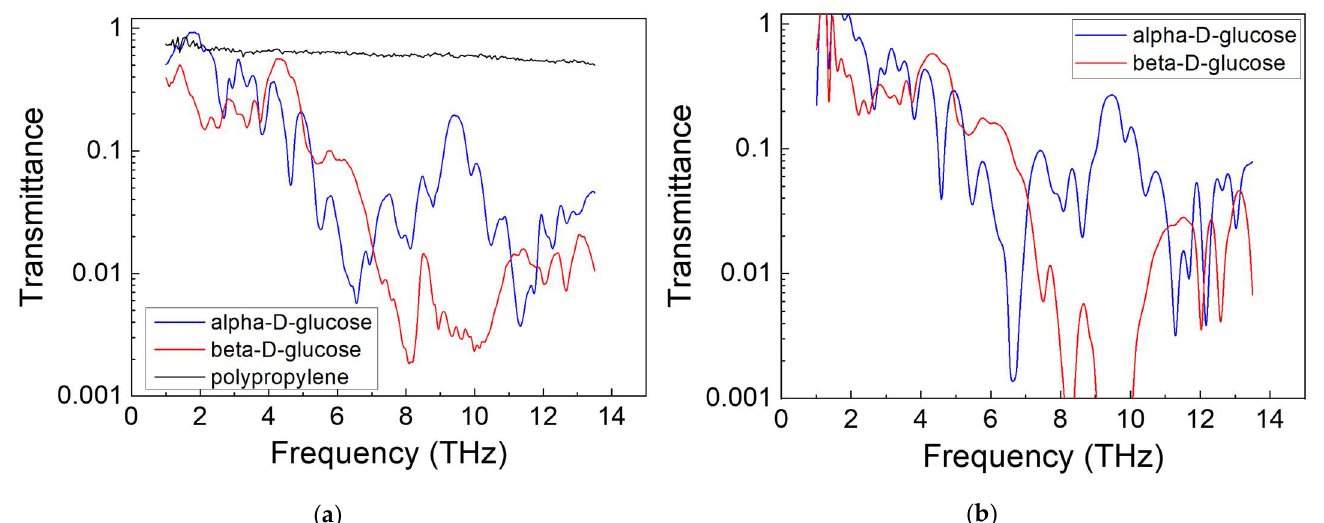
Figure 3. ( a ) Plots of the experimentally obtained THz transmission characteristics of α- and β-D- glucose and host material of polypropylene samples, characterized using our frequency-domain THz spectroscopic system. ( b ) THz transmission spectra of α- and β-D-glucose samples measured by using the conventional FTIR method.